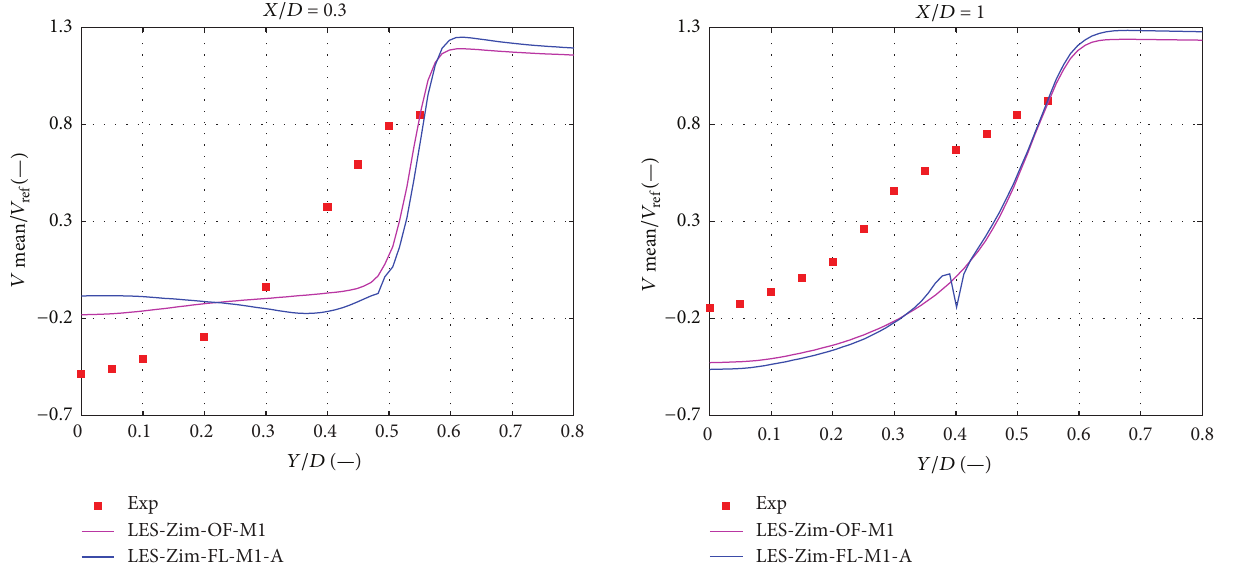
Figure 21: Velocity profiles for Fluent LES-ZIM-FL-M1-A, experimental results, and Zimont